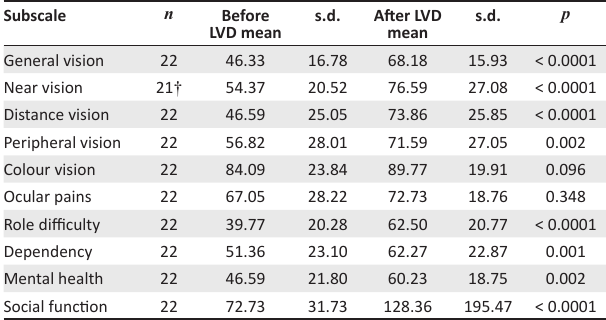
FIGURE 2: Difficulty performing task: (a) before low vision assessment ( N = 62), (b) after obtaining and using low vision devices for 3 months ( N = 22). TABLE 3: Comparison of effect of low vision